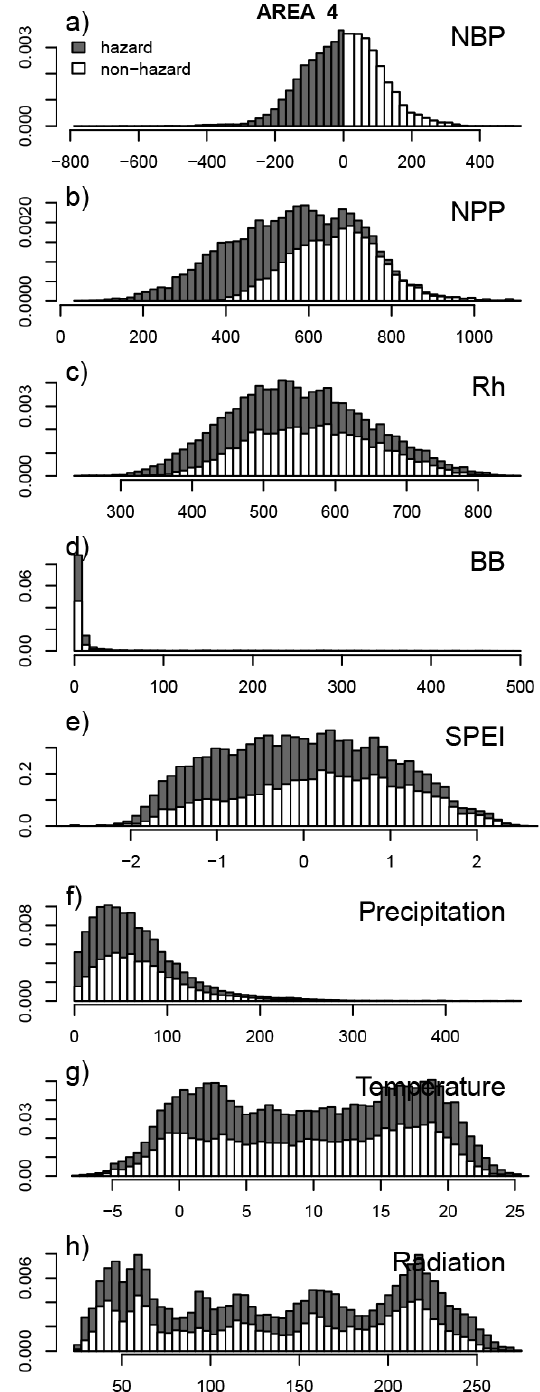
Figure B5. Probability distributions for area 4 (see Fig. B1) of (a) NBP and its contributions (b) NPP, (c) Rh, and (d) BB (all in gCm − 2 a − 1 ) as well as monthly values for (e) SPEI (dimen- sionless), (f) precipitation (mmmonth − 1 ), (g) temperature ( ◦ C) and (h) short-wave downward radiation (Wm − 2 ). Dark shading denotes values in the hazard group, white shading in the non-hazard